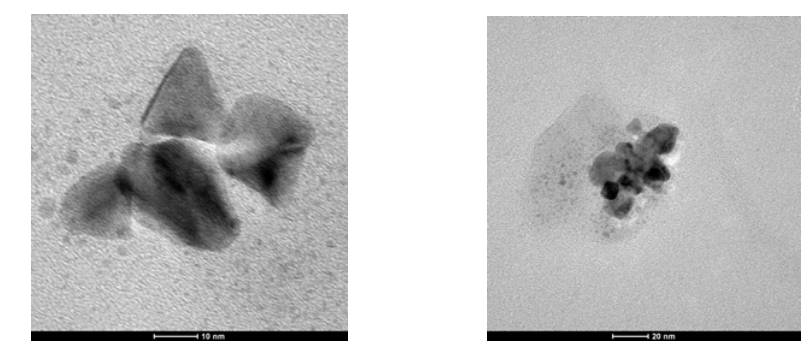
Figure 7. TEM micrograph of 4 -Pd(0).